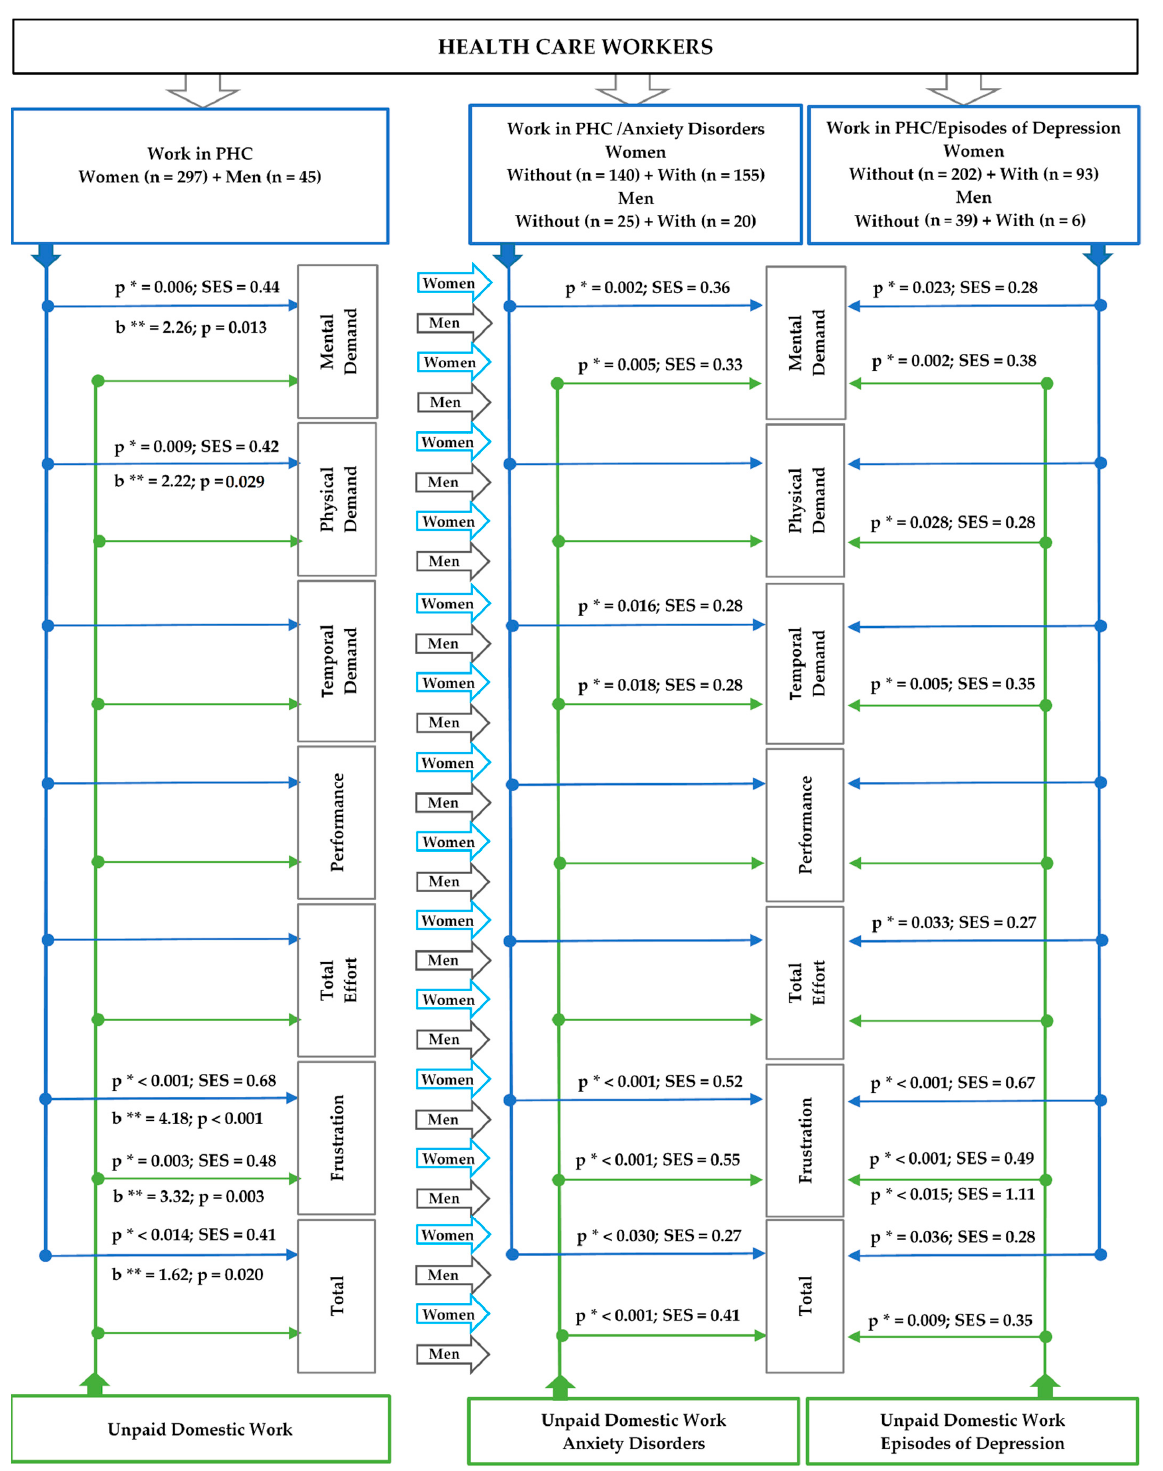
Figure 2. Synthesis of the results evaluated as statistically significant from the analysis by gender in terms of workload in PHC and the results of this workload when considering, one at a time, the association with anxiety disorders and with episodes of depression. * Test t -student; ** regression coefficient (95% confidence interval) adjusted for age, marital status, education level, number of children, monthly income, other parallel work, profession, time in the profession, time working in PHC and total weekly working hours; SES: standardized effect size